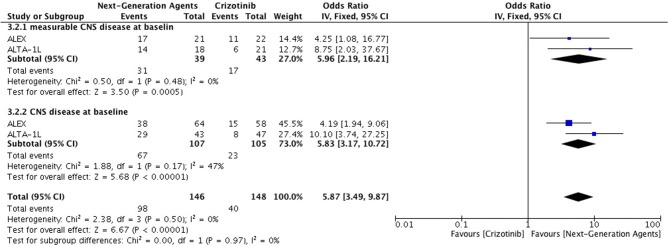
Forest plot of meta-analysis of the Intra-cranial response rate (ICRR) showing comparison of Next generation agents to crizotinib in ALK positive NSCLC.